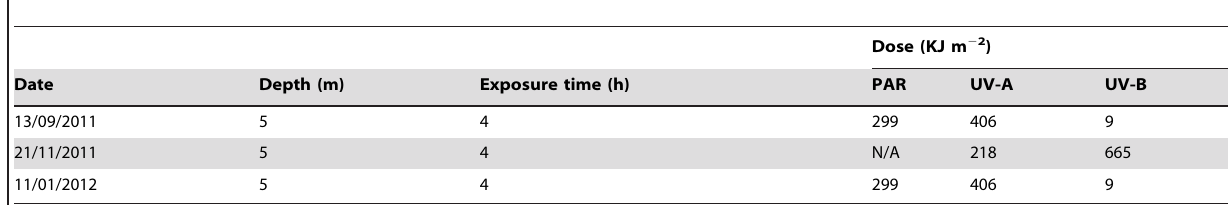
Table 2. Summary of ammonium production experiments with natural marine samples carried out during this